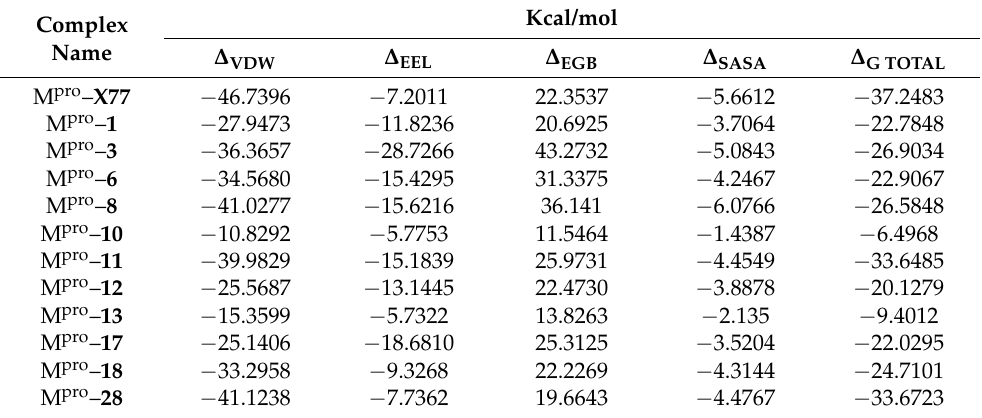
Table 2. The MMGBSA analysis of X77 and eleven hits for M pro